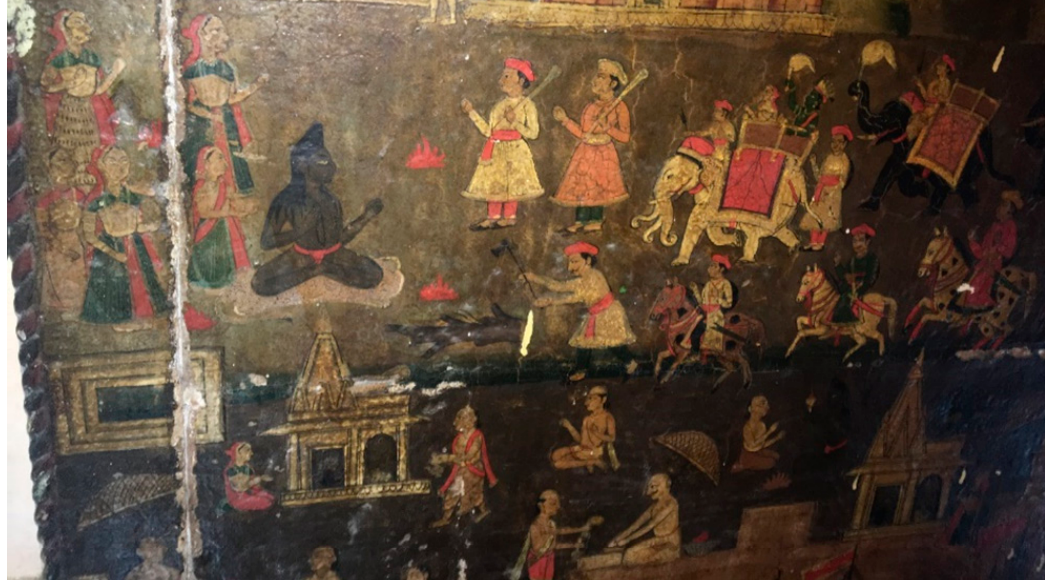
Figure 5. Detail of the P ā r ś va-Kama ṭ ha encounter watercolor on the backside of the main shrine